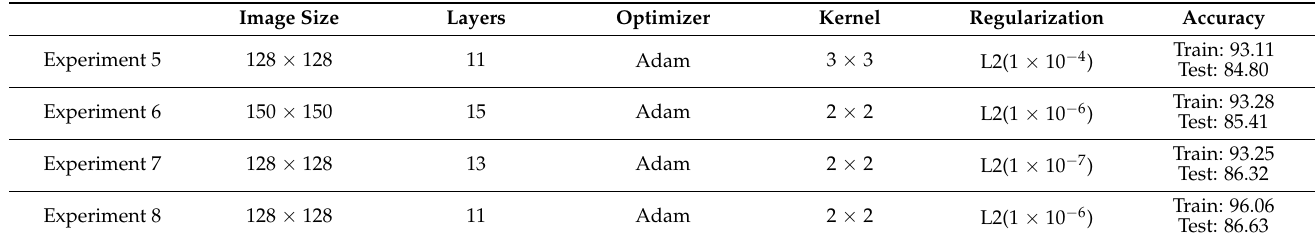
Table 2. Effect of various parameters of CNN with